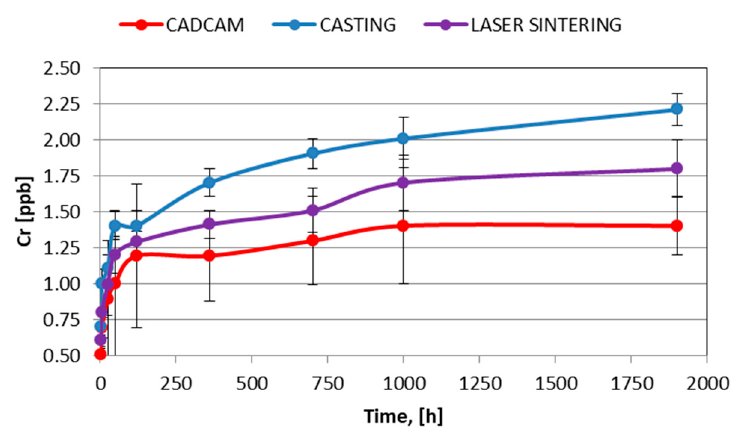
Figure 8. Cr-release for different test times and types of manufacturing methods.